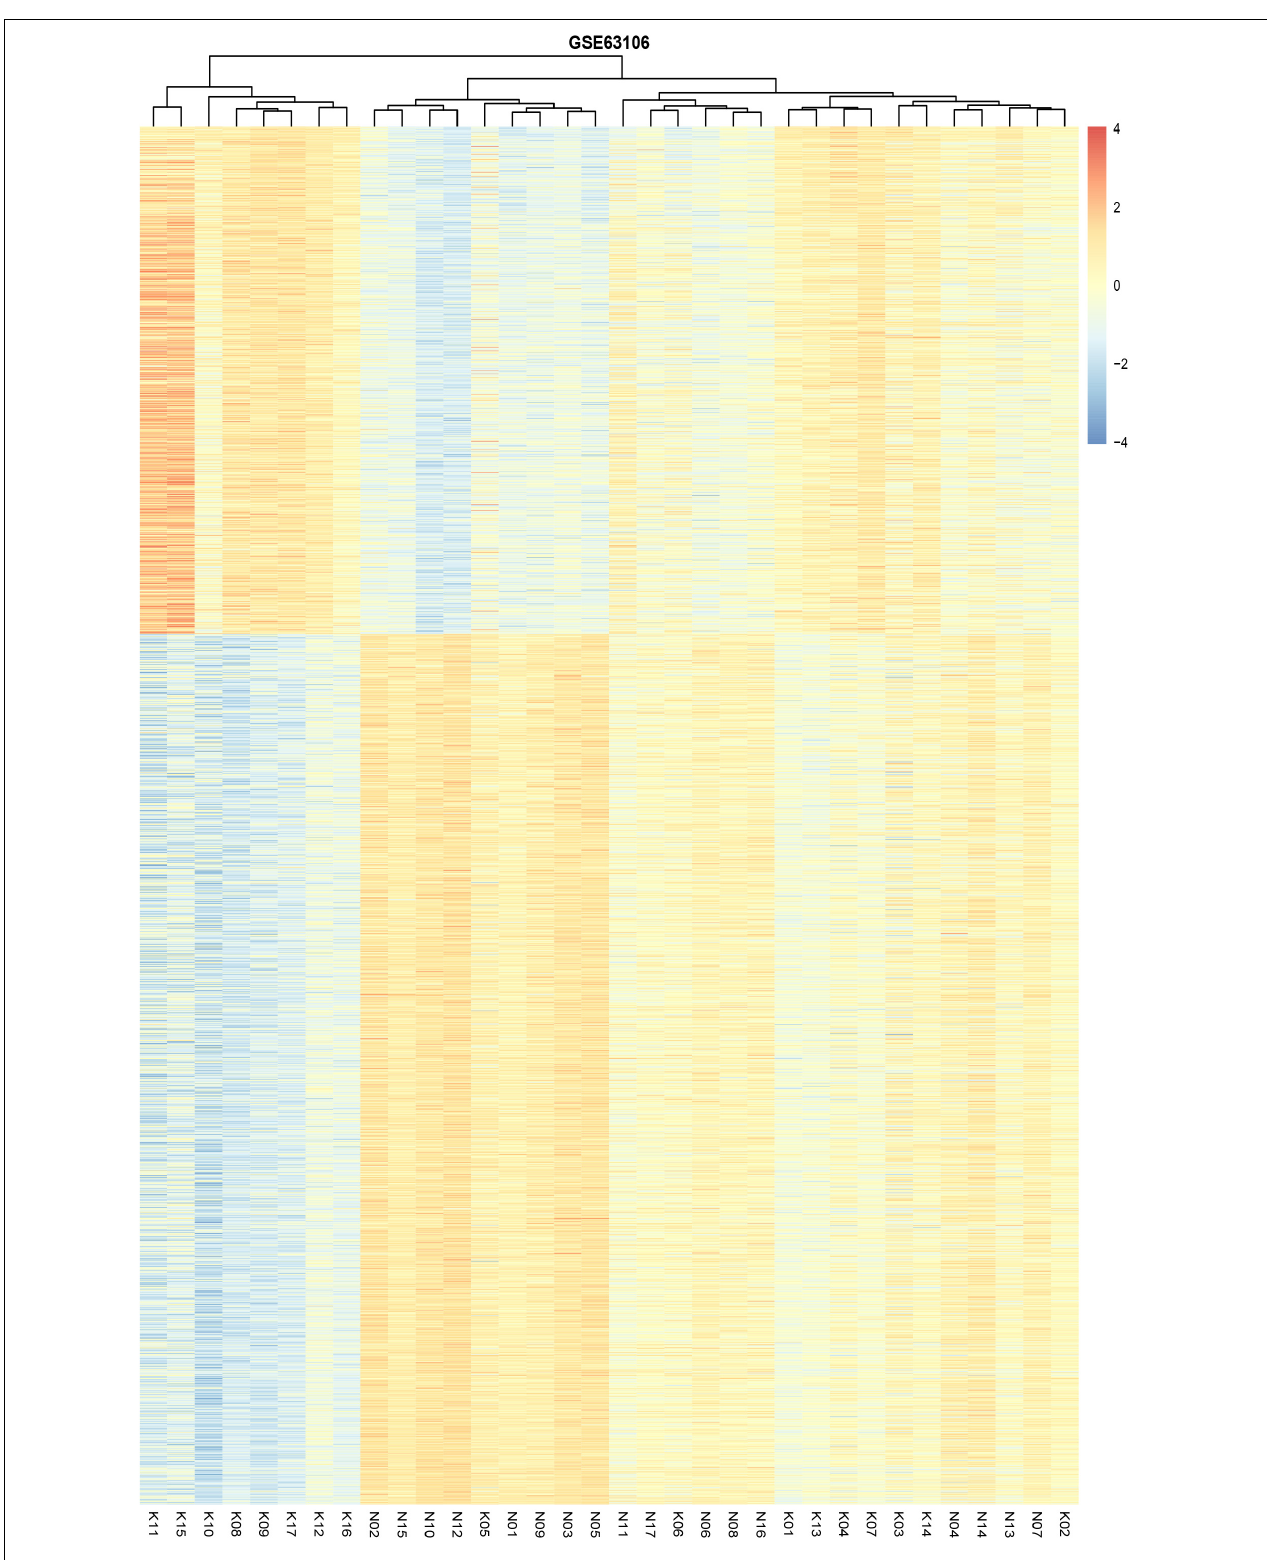
FIGURE 1 | Unsupervised hierarchical clustering of the methylation levels of the DMS from the preserved and affected cartilage, based on the cut-off criteria of abs(logFC) > 0.1 and adjusted P -value < 0.05.